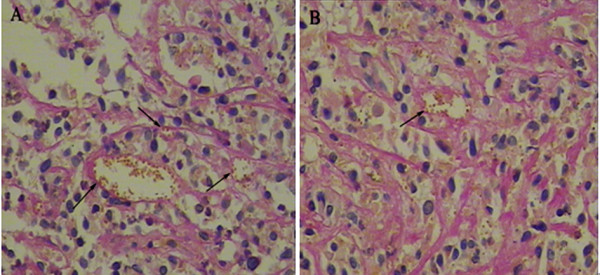
CD34 and PAS double staining on the C918 human uveal melanoma xenograft sections. (A) Control; (B) 75 mg/kg/day Genistein group; VM channel (arrow) is lined by PAS-positive materials and there are red cells in the center of the channels. (Magnification: × 400)